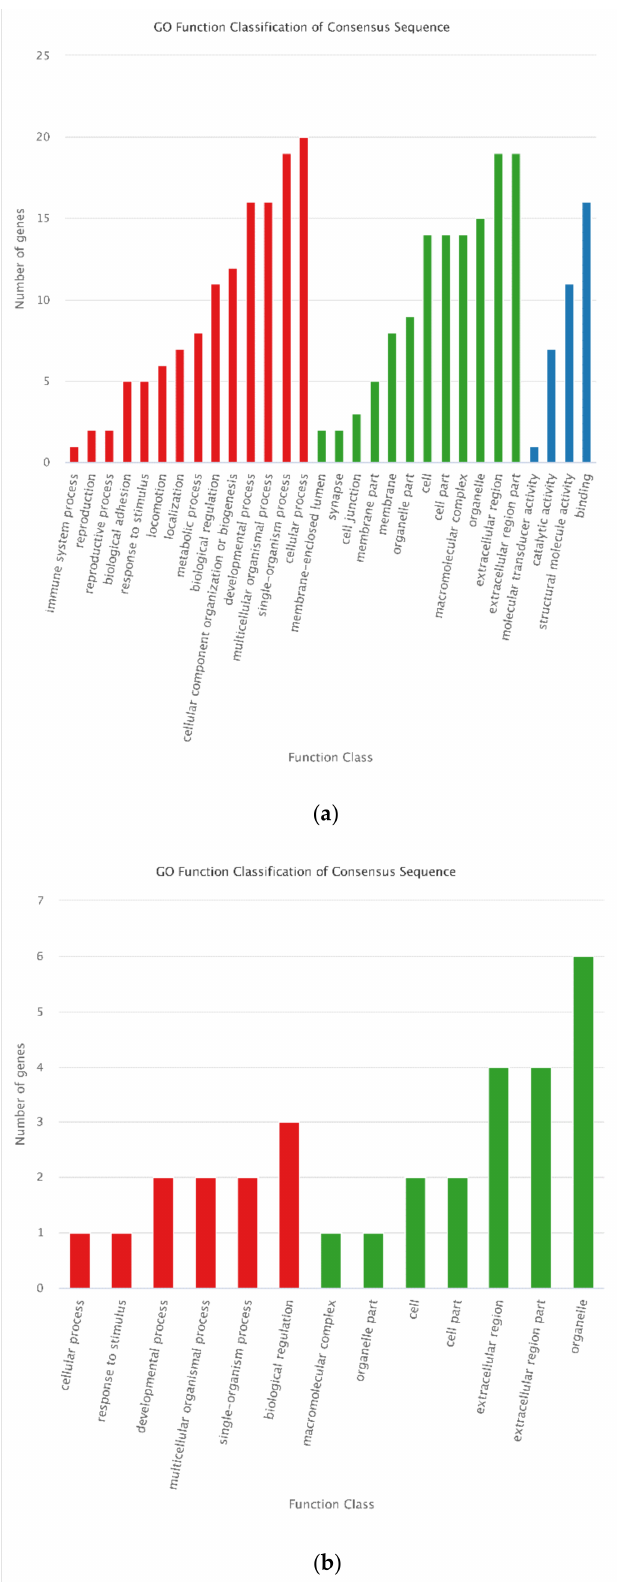
Figure 13. GO classification of DEGs and DEPs with the same trend. For GO anno-tation, the abscissa is the GO term, and the ordinate indicates the number of DEGs annotated to GO terms. ( a ) GO classification of DEGs with the same trends to DEPs. ( b ) GO classification of DEPs with the same trends to